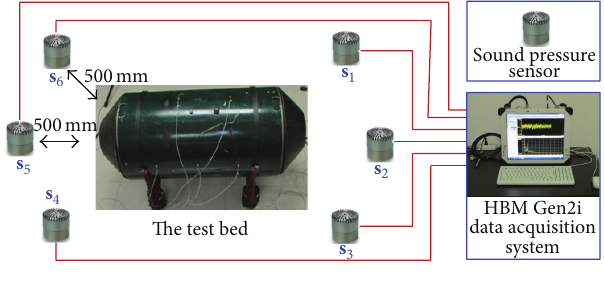
Figure 5: The framework of the measuring system.